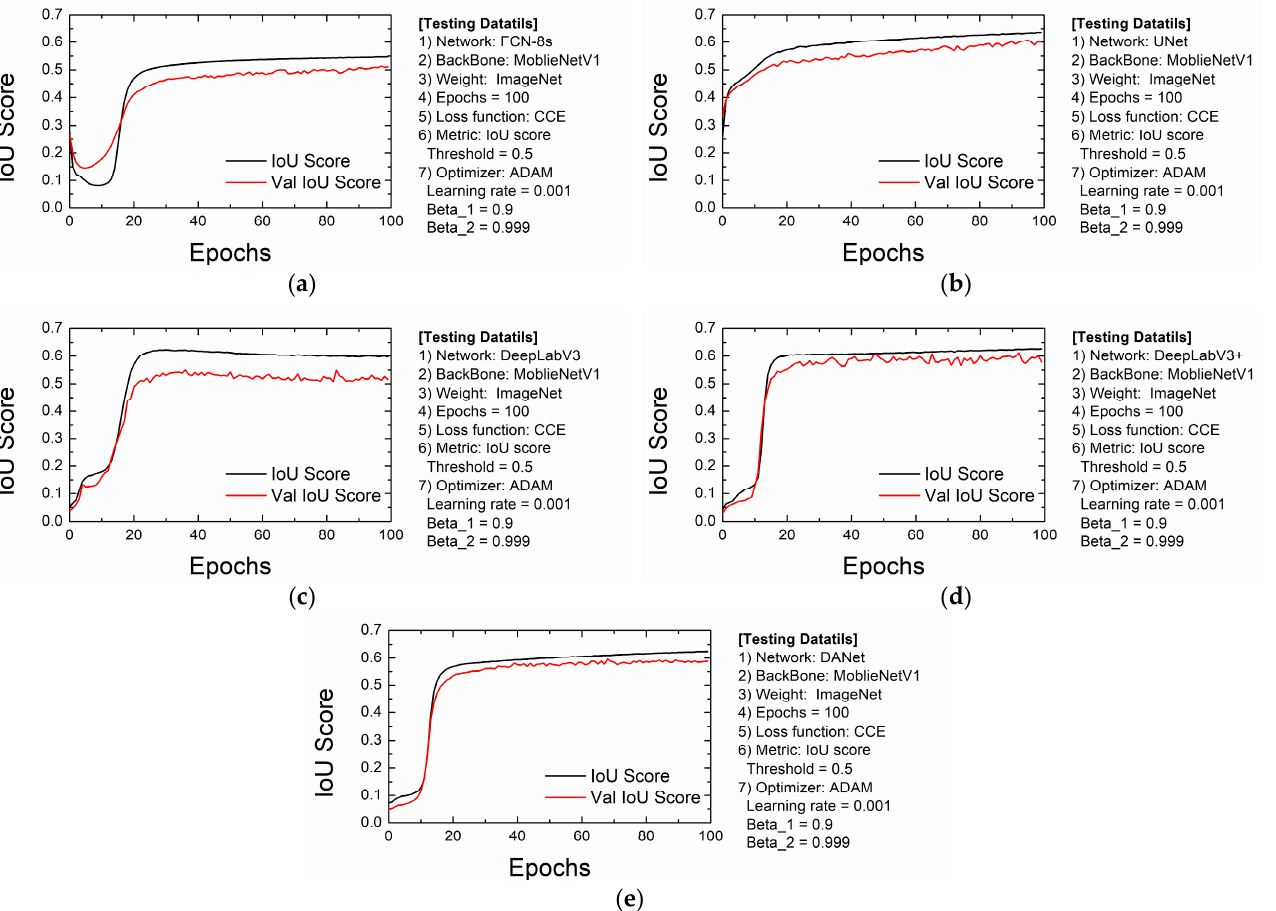
Figure 10. IoU score versus Epochs: ( a ) FCN, ( b )UNet, ( c ) DeepLabV3, ( d ) DeepLabV3+, and ( e ) DANet.